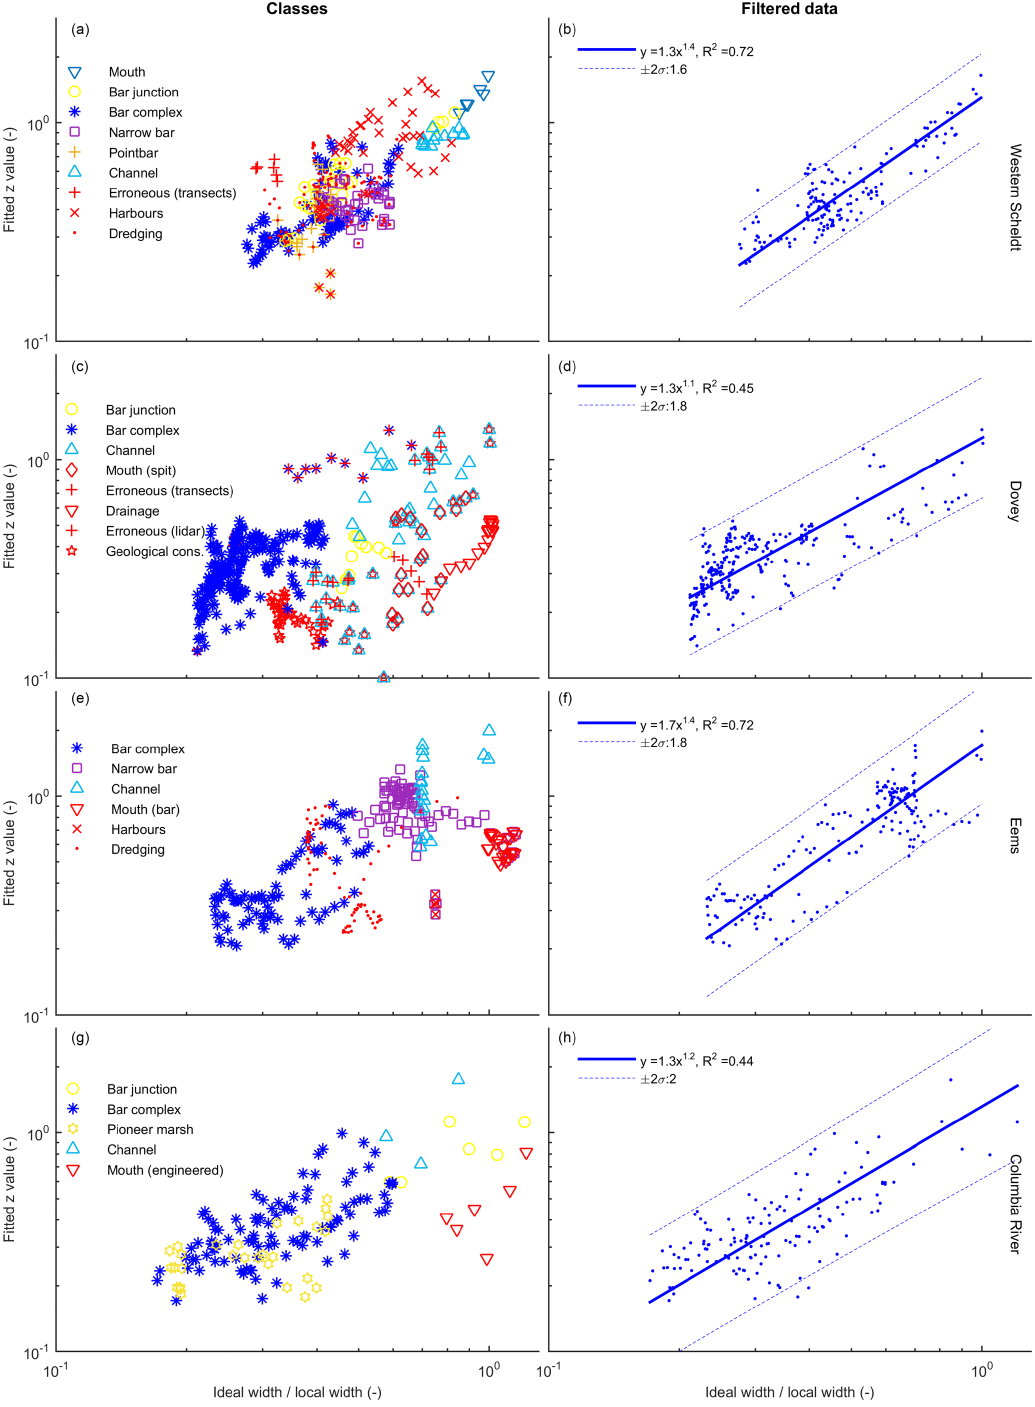
Figure 6. Results of hypsometry fitting in which clustering indicates a relation to planform geometry. (a, c, e, g) z values were fitted for cross-channel transects in the bathymetry of four estuaries and plotted by morphological classification. (b, d, f, h) Regressions for z value as a function of ideal width divided by local width. Data points that were influenced by human interference, bedrock geology, or errors in methodology or data, indicated in red (a, c, e, g) , were excluded. Confidence limits are plotted at 2 standard deviations above and below the regression and their multiplication factor compared to the trend is given in the